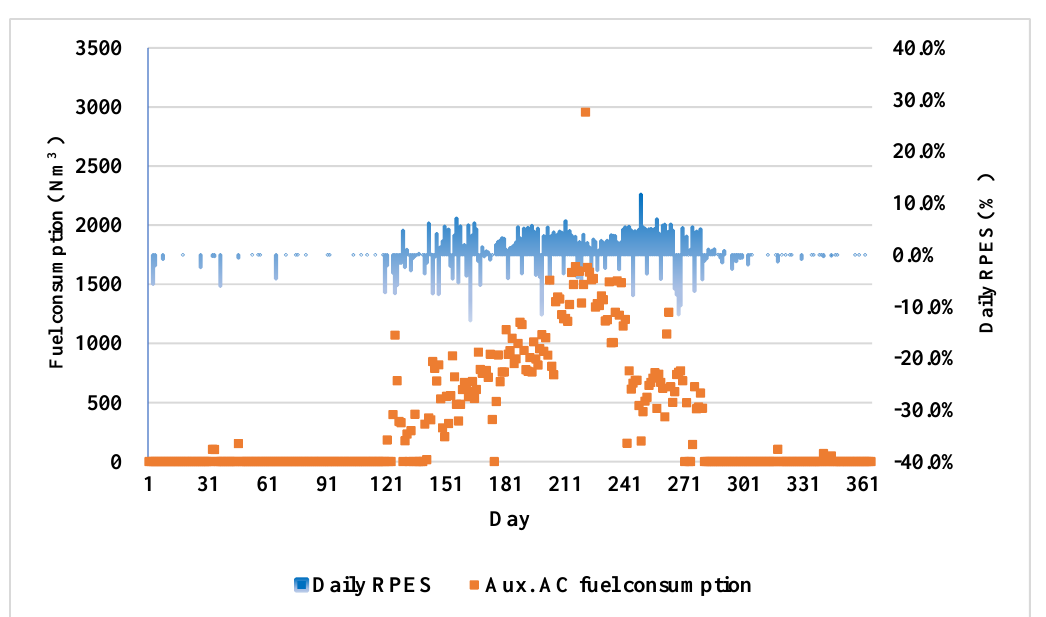
Figure 18. Profiles of the daily RPES and the LNG consumption of auxiliary absorption chillers for Case B.